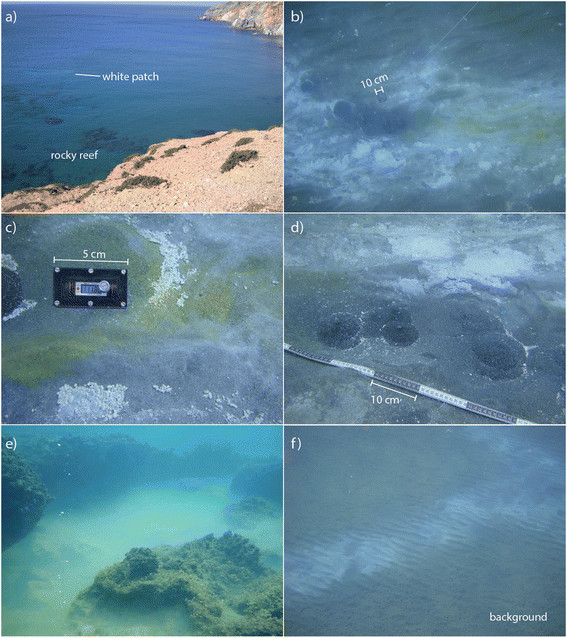
Pictures of hydrothermal features in Palaeochori Bay. (a) White patches and a rocky reef as seen from cliffs overlooking the bay. (b) The physical appearance of the hydrothermal features was highly heterogeneous, ranging from patches of white to orange/yellow precipitates grading into non-pigmented background sediments. (c) The yellow and orange precipitates tended to form toward the center of the features where pore water temperatures were highest. (d) Gas flow from several vent mounds formed streams of bubbles in the water column. (e) Saline brine accumulated within a depression of a rocky reef. (f) Background sediments with no visible evidence for venting or microbial cover were used as control sites.